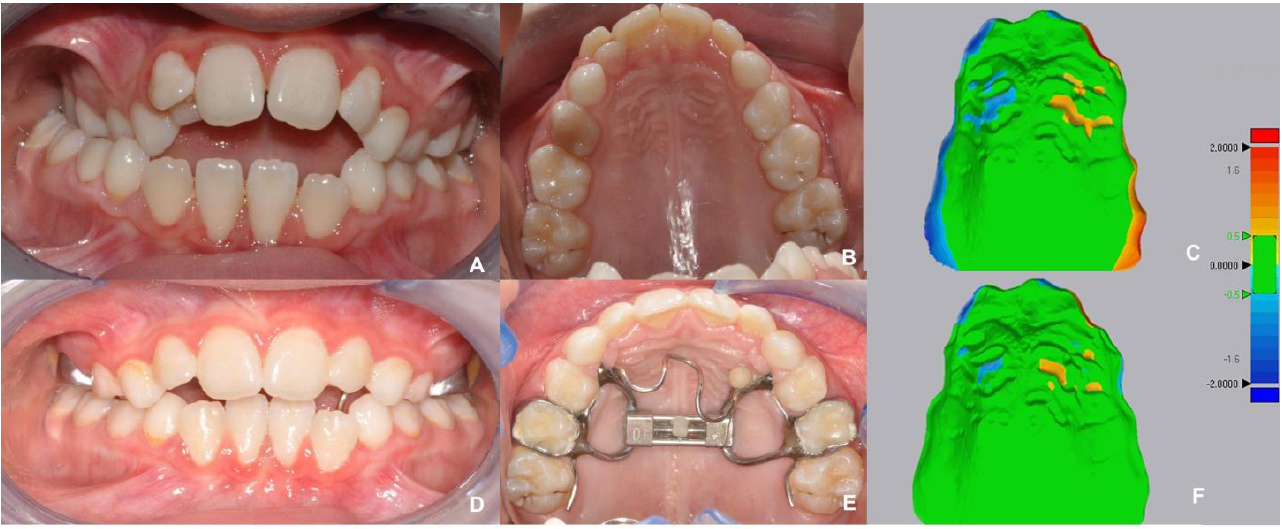
Figure 8. Example of computer-assisted analysis of facial asymmetry using reverse engineering 3-Matic software (Materialise, Leuven, Belgium). ( A ), Facial scan; ( B ), definition of the mirroring plane; ( C , D ), mirrored facial scans to assess asymmetry.